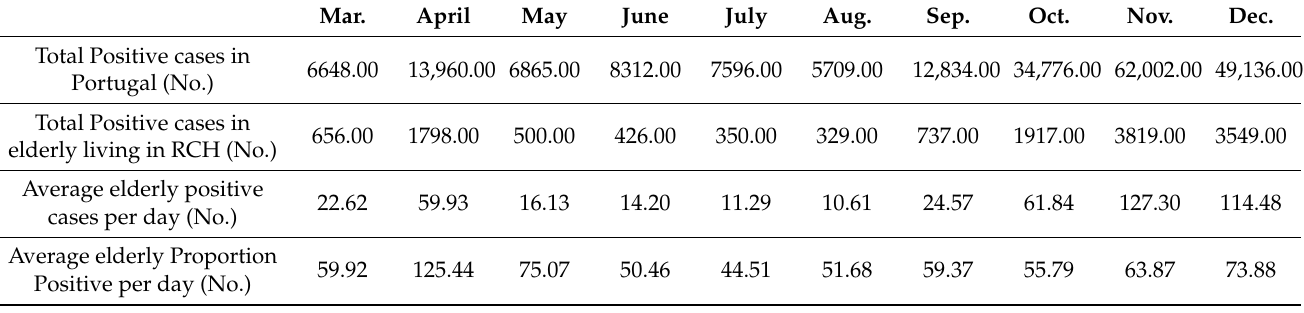
Table 1. Total Positive Cases, Mean of Positive Cases and Proportion Positive by 1000 patients.